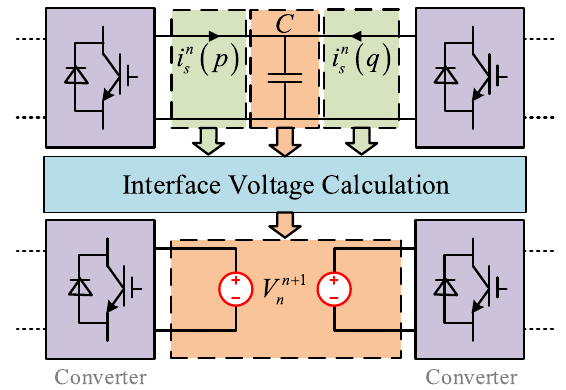
Fig. 4 System decoupling